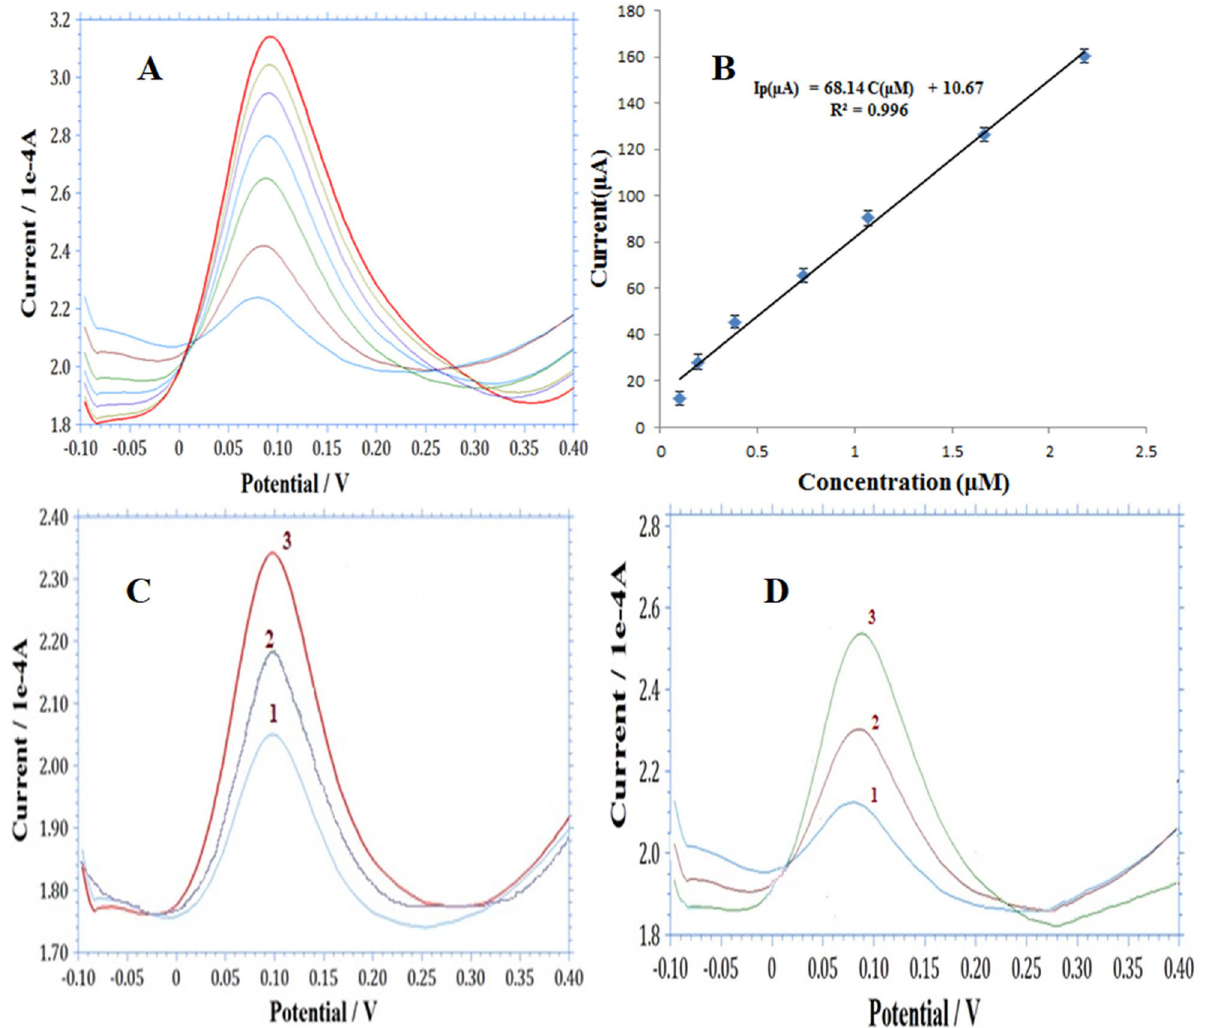
Figure 8. ( A ) Square wave adsorptive stripping voltammograms at GN:ZnO NC/GCE at different concentrations of p-NP using phosphate buffer (pH 6.8). Deposition-potential: − 1.0 V, deposition-time: 300 s. ( B ) Plot of concentration of p-NP aganist peak current with error bars. ( C ) SW-AdS voltagrams for p-NP determination using standard adition method spiked with (1) 35.61 × 10 –8 M ,(2) 71.22 × 10 −8 M and 106.83 × 10 – 8 M p-NP in river water sample. ( D ) SW-AdS voltagrams for p-NP determination using standard adition method spiked with (1) 35.61 × 10 –8 M , (2) 71.22 × 10 −8 M and 106.83 × 10 –8 M p-NP in ground water sample.